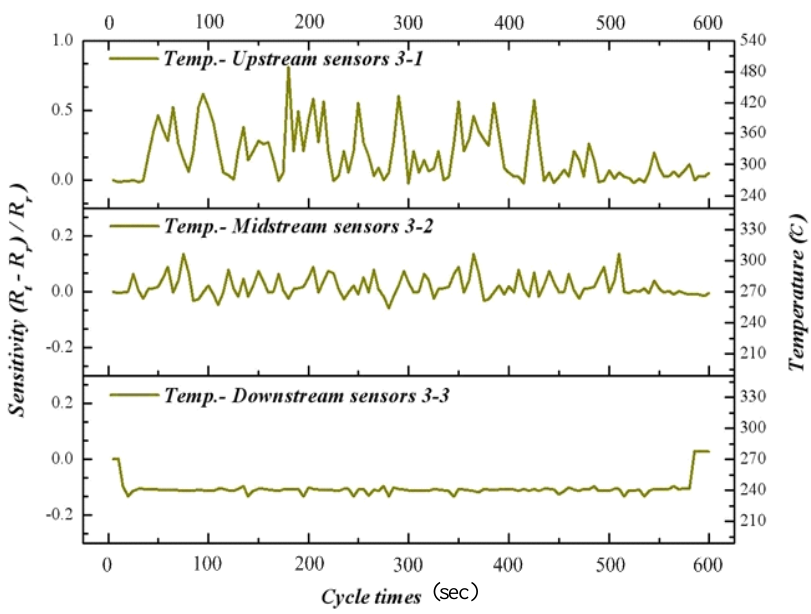
Figure 10. Inner temperature distribution of micro reformer at area 3-1, 3-2, 3-3 (OSRM; 270  C).